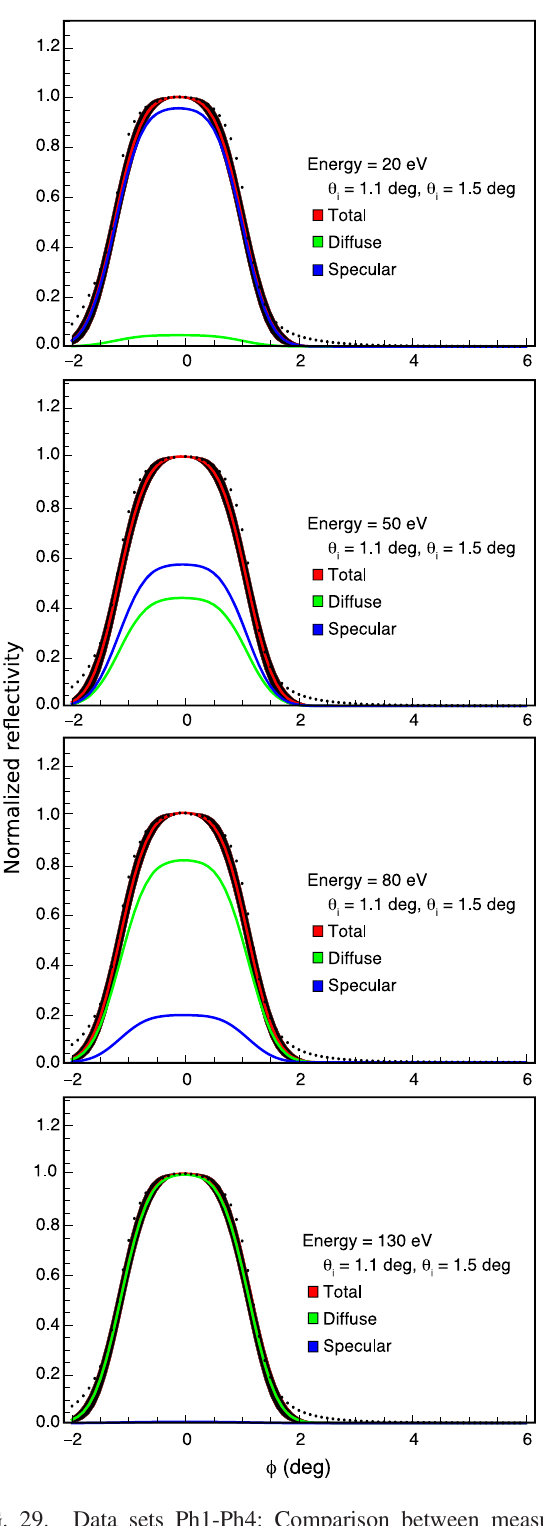
FIG. 29. Data sets Ph1-Ph4: Comparison between measure- ment and X-ray scattering model, ϕ scans, for θ 1 ¼ 1 . 5 °, θ ¼ 2 . 6 ° and various energies. The gray band represents 2 the mean-prediction 95% confidence level associated with the